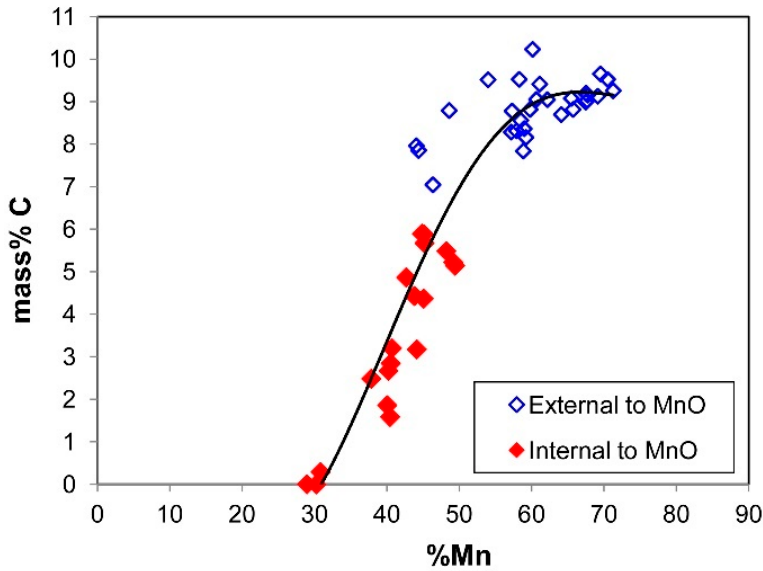
Figure 8. SEM-WDS alloy composition data.